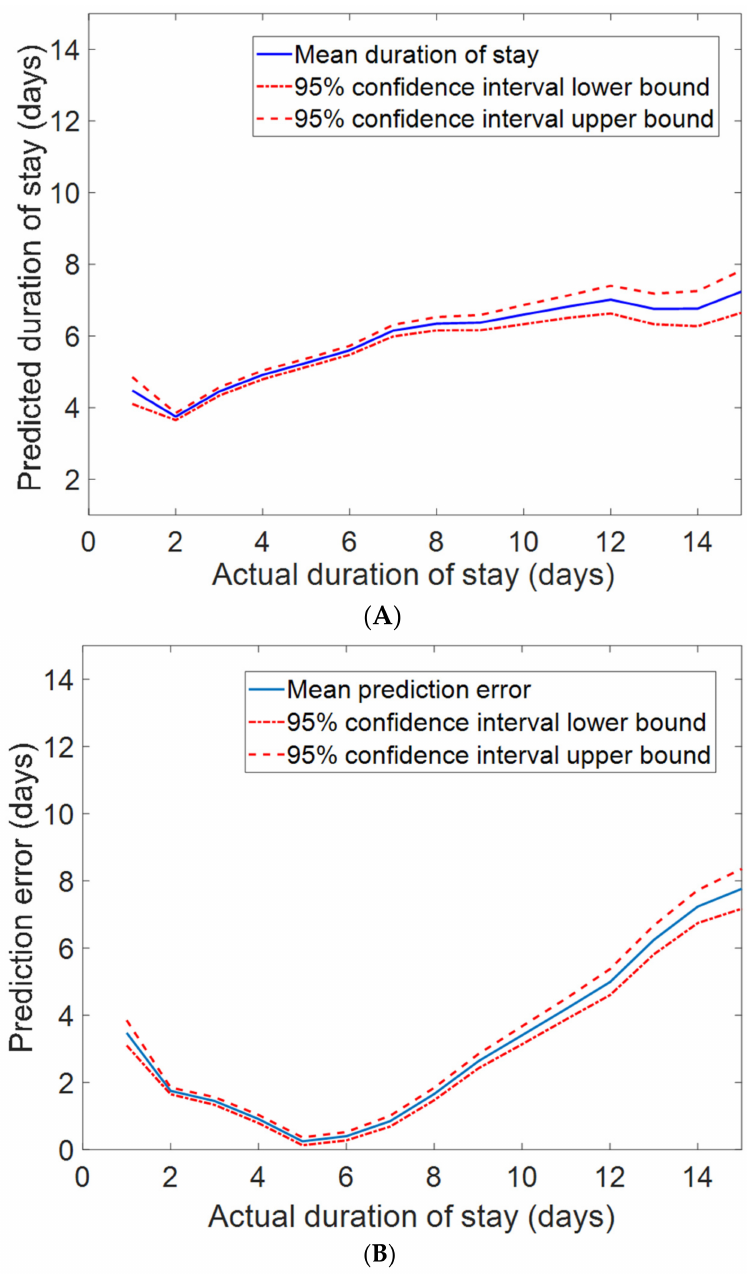
Figure 5. ( A ) The mean predicted duration of stay along with the 95% confidence intervals versus the actual duration of stay. ( B ) The absolute value of the mean prediction error along with the 95% confidence intervals versus the actual duration of stay. The proposed model achieved a mean absolute error (MAE) of 2.543 days (95% CI: 2.499–2.586), which is superior to the MAE of the classifier using all features (FS1) as